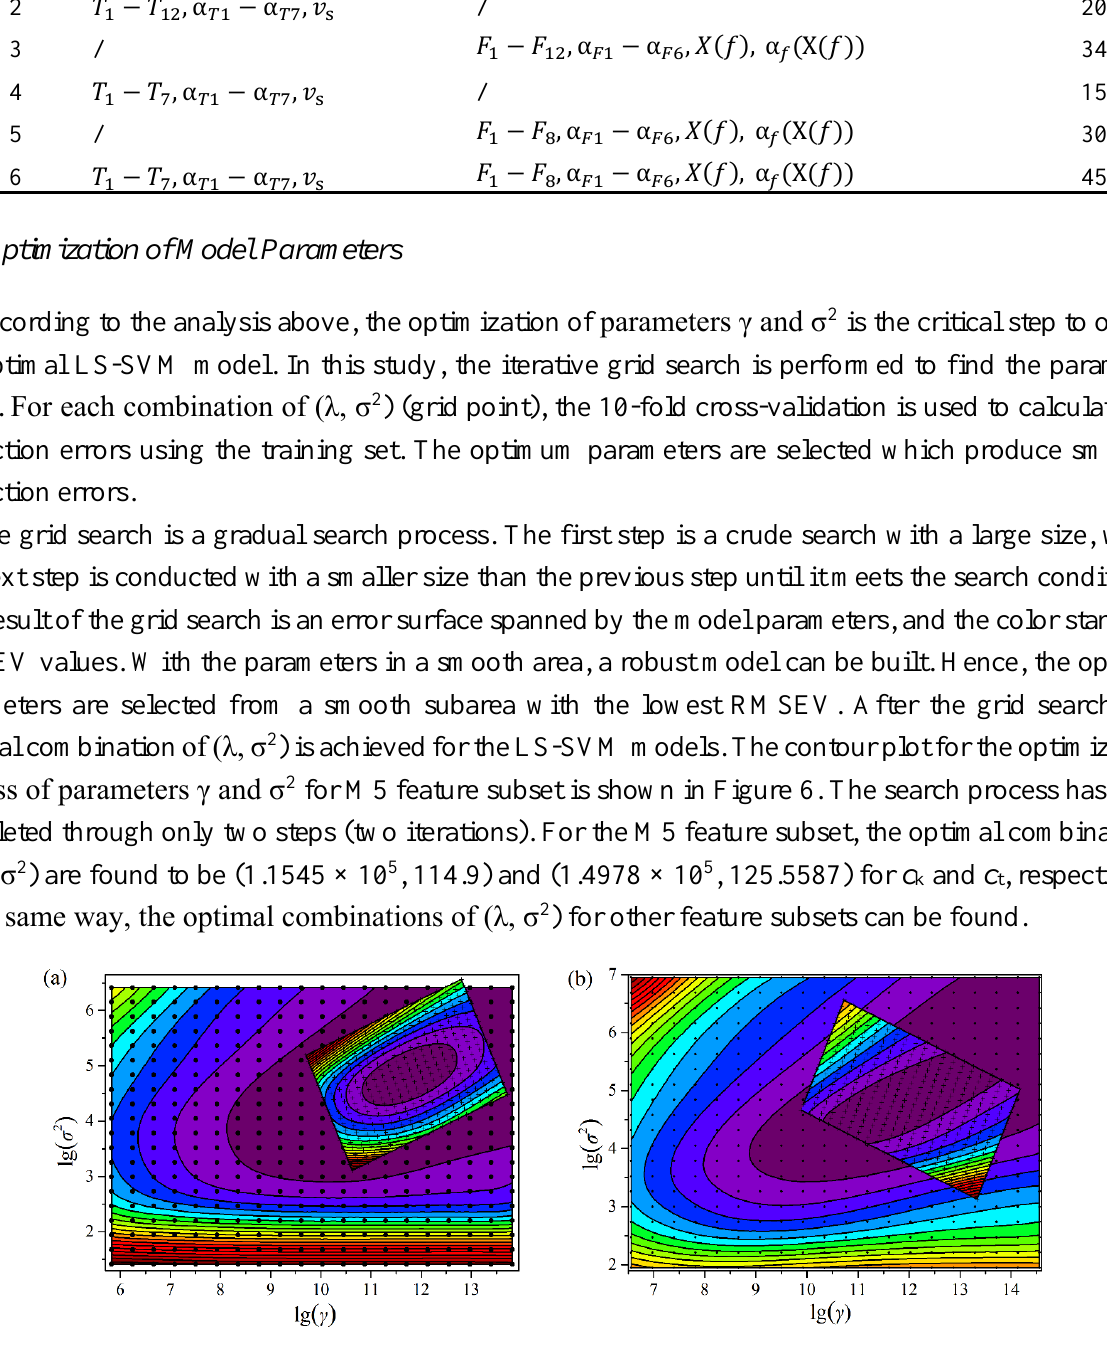
( b ) c t . The grids “·” and “+” are 10 × 10 in the first step and the second step, respectively. The color stand for the value of